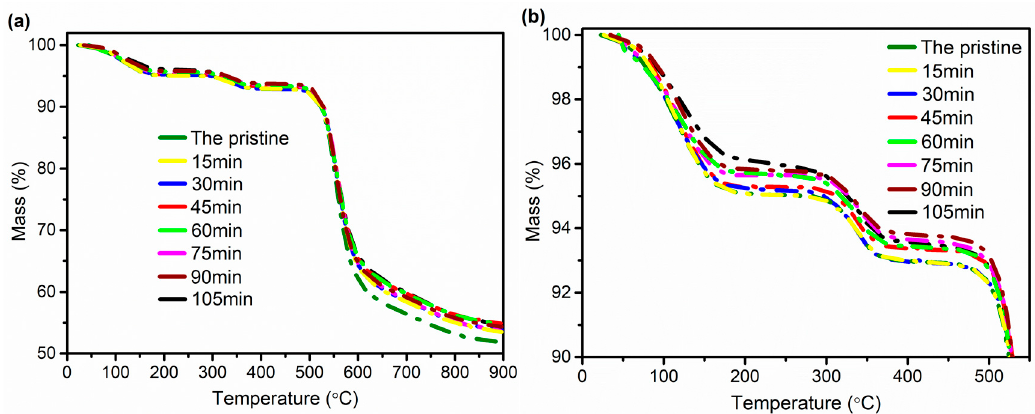
Figure 12. The thermogravimetric curves (~0–900 ◦ C) ( a ) and (~0–550 ◦ C) ( b ) of the pristine and treated F-III fibers in Sc-CO 2 .